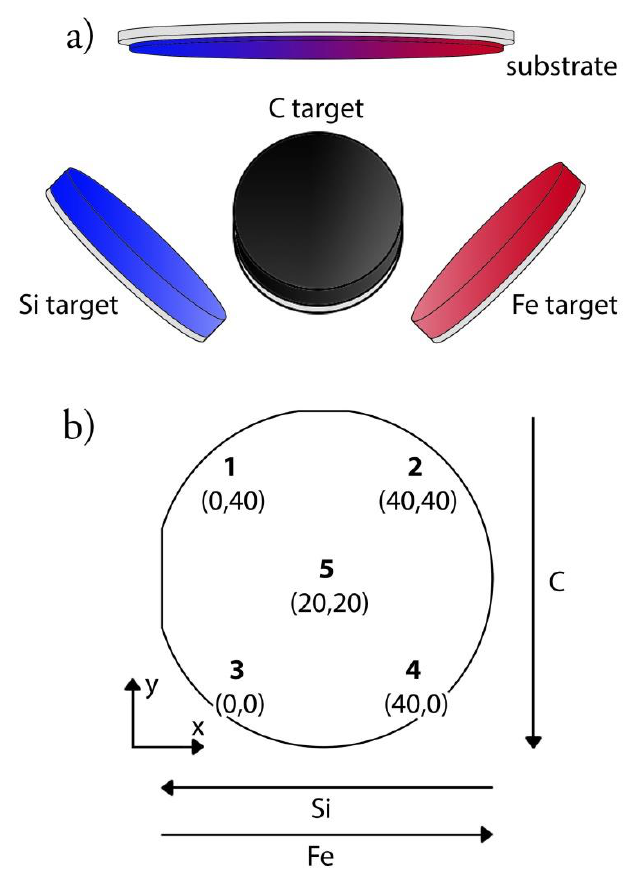
Figure 1. Deposition setup displaying ( a ) the three targets (silicon, iron, and carbon) and the position of the silicon wafer substrate, and ( b ) a schematic image of the sample with the five investigated points and their coordinates in mm with point 3 as origin.